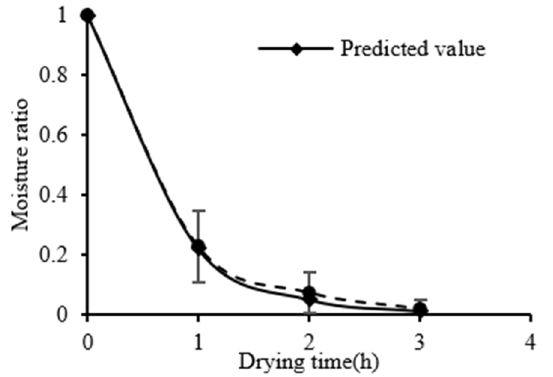
Figure 6. Validation of the drying model.